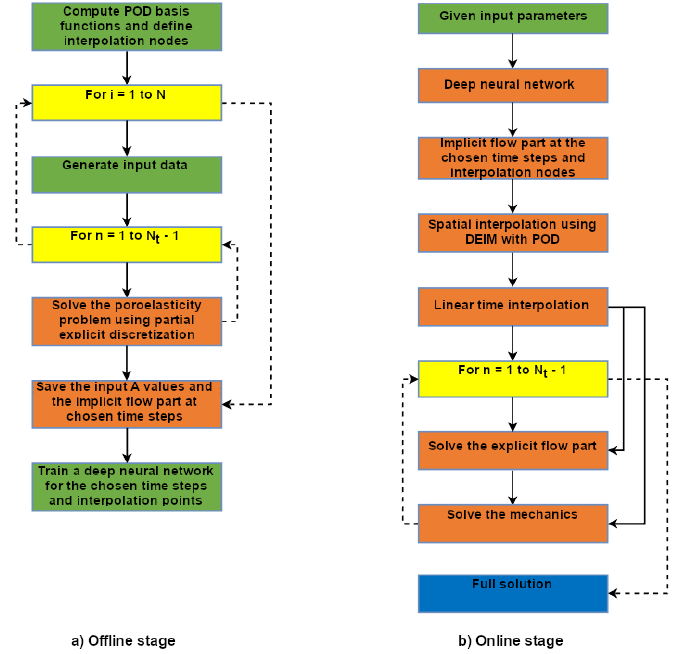
Figure 2. Flow charts of the offline and online stages of partial learning using partially explicit discretization with limited